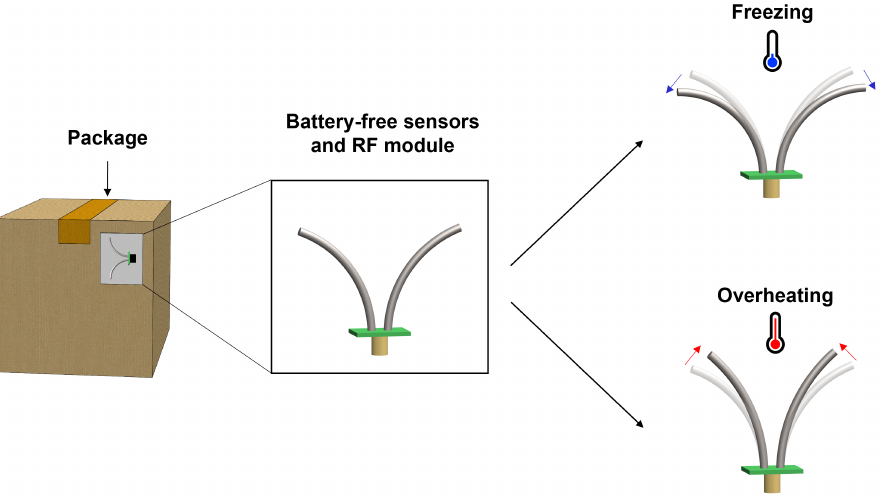
Figure 1. Battery-free shape memory alloy antenna sensors that record the critical temperature information during